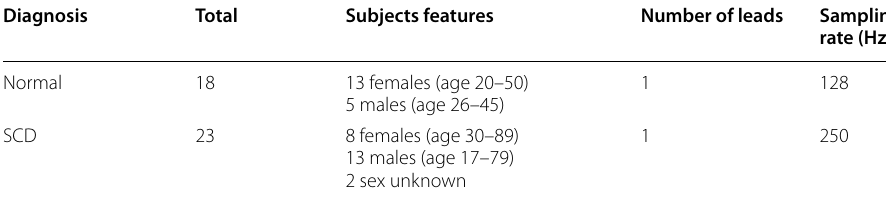
Table 1 Details of the data used in this work Diagnosis Total Subjects